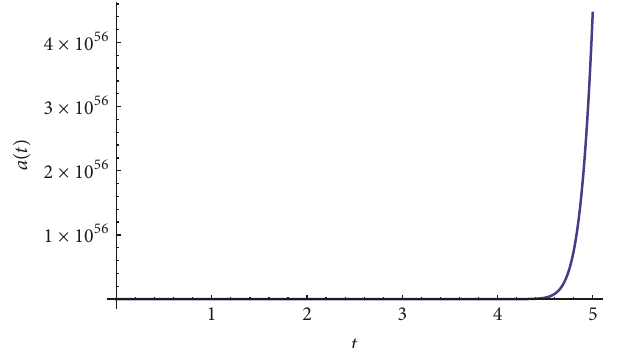
Figure 1: Numerical profile of 𝑎(𝑡) with initial conditions 𝑎(0) = 10 −20 , ̇𝑎(0) = 10 −20 , ̈𝑎(0) = 10 −17 , 𝛽 = −100 , and 𝑘 = 0 .